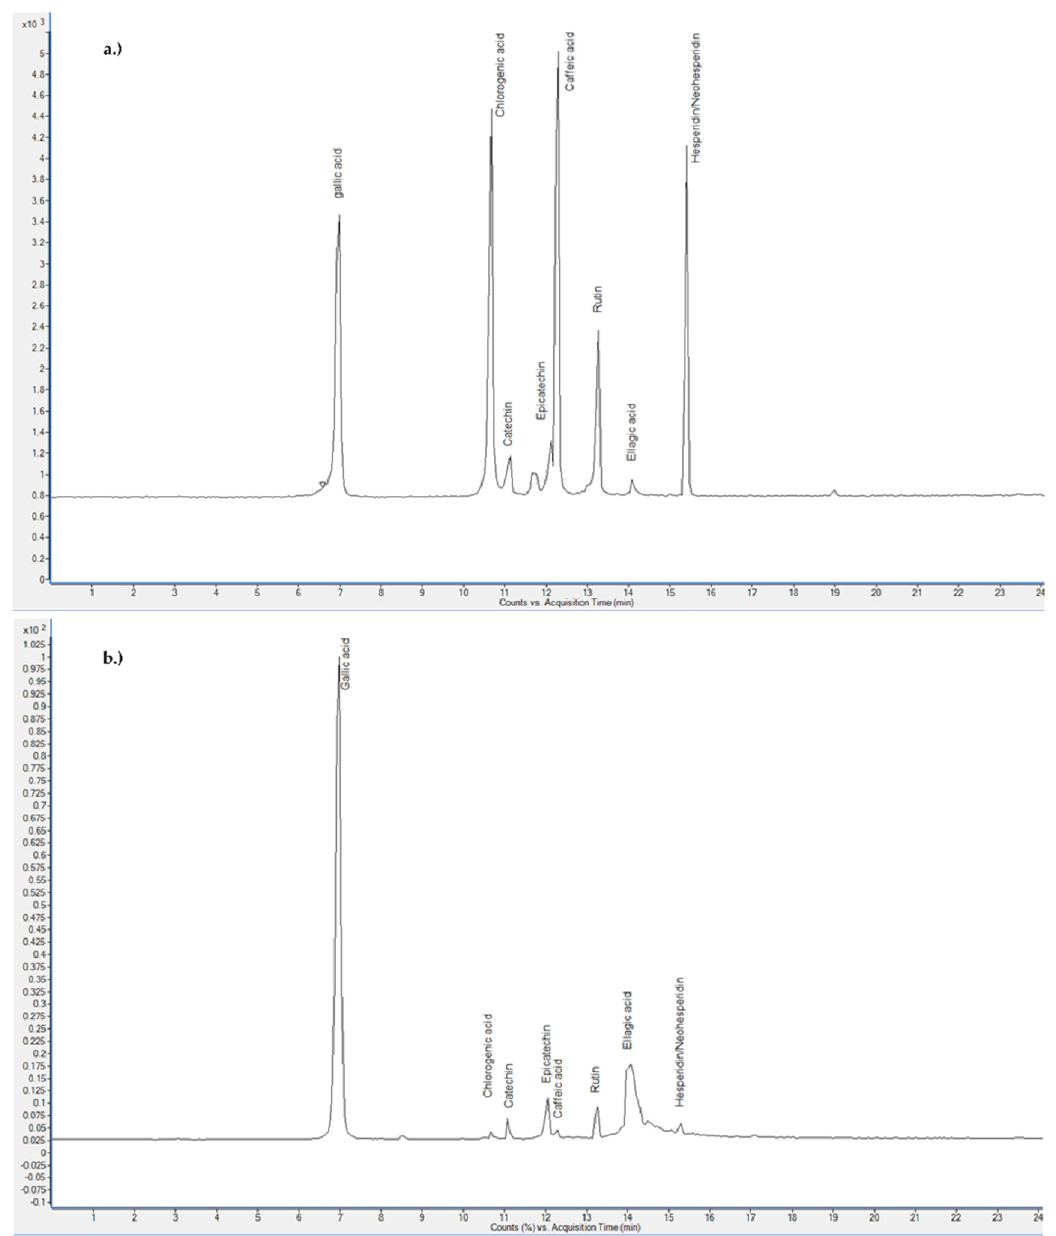
Figure 5. LC-MS/MS chromatograms for ( a ) standards and ( b ) SFE extract obtained at operating pressure of 20 MPa.